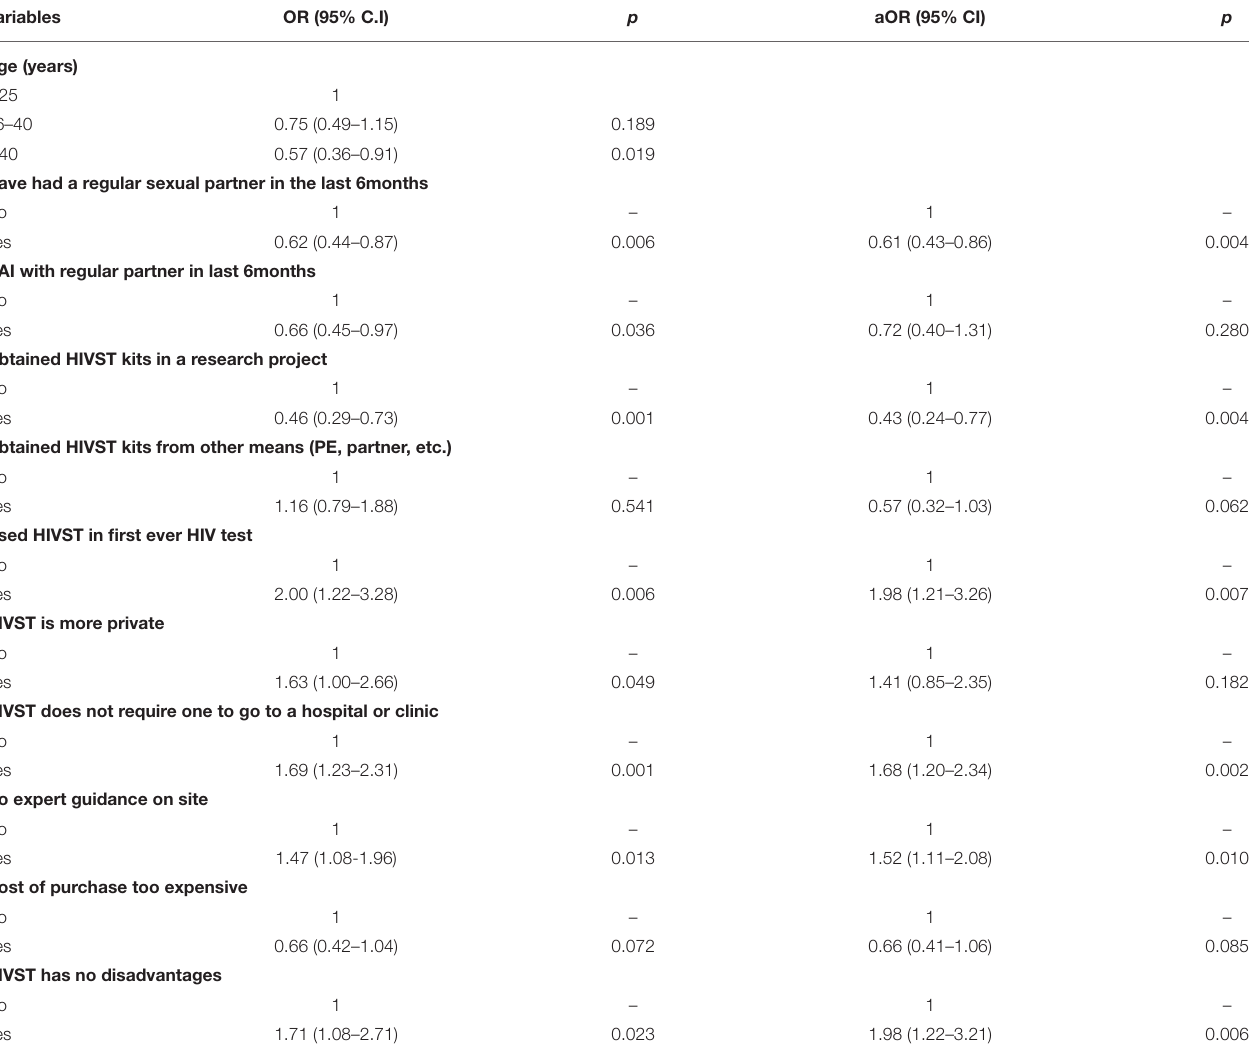
TABLE 4 | Factors associated with recent HIVST (self-testing at least once last year) among MSM in Jiangsu province, China 2020.